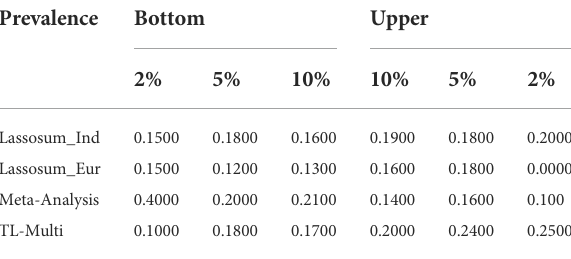
TABLE 2 Case prevalence of 2, 5, and 10% for the top and bottom quantiles of the PRS distribution in the analysis of asthma study with the target Indian population and auxiliary European population, generated by Lassosum, meta-analysis, and TL-Multi. Prevalence